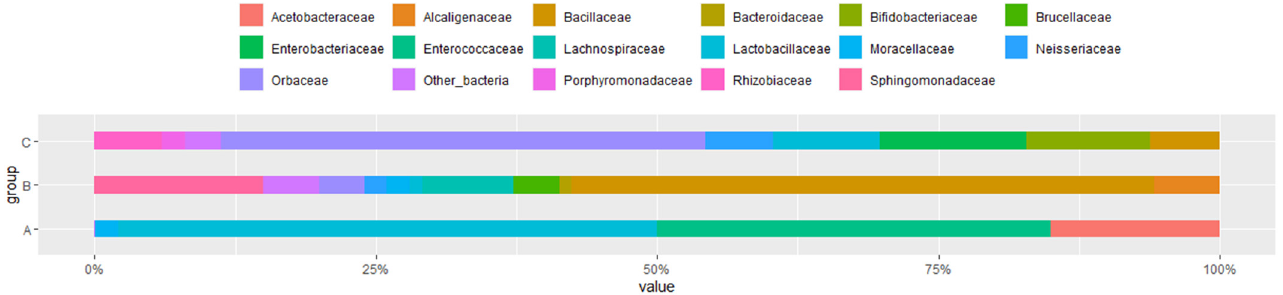
Figure 2. Relative abundance of the major phylum gut microbiota of larval (A), pupal (B), and adult (C) honeybees, Apis cerana, with cut-off of 1%. The abundance of different phyla in the sample is shown by the color gradient of the color block.